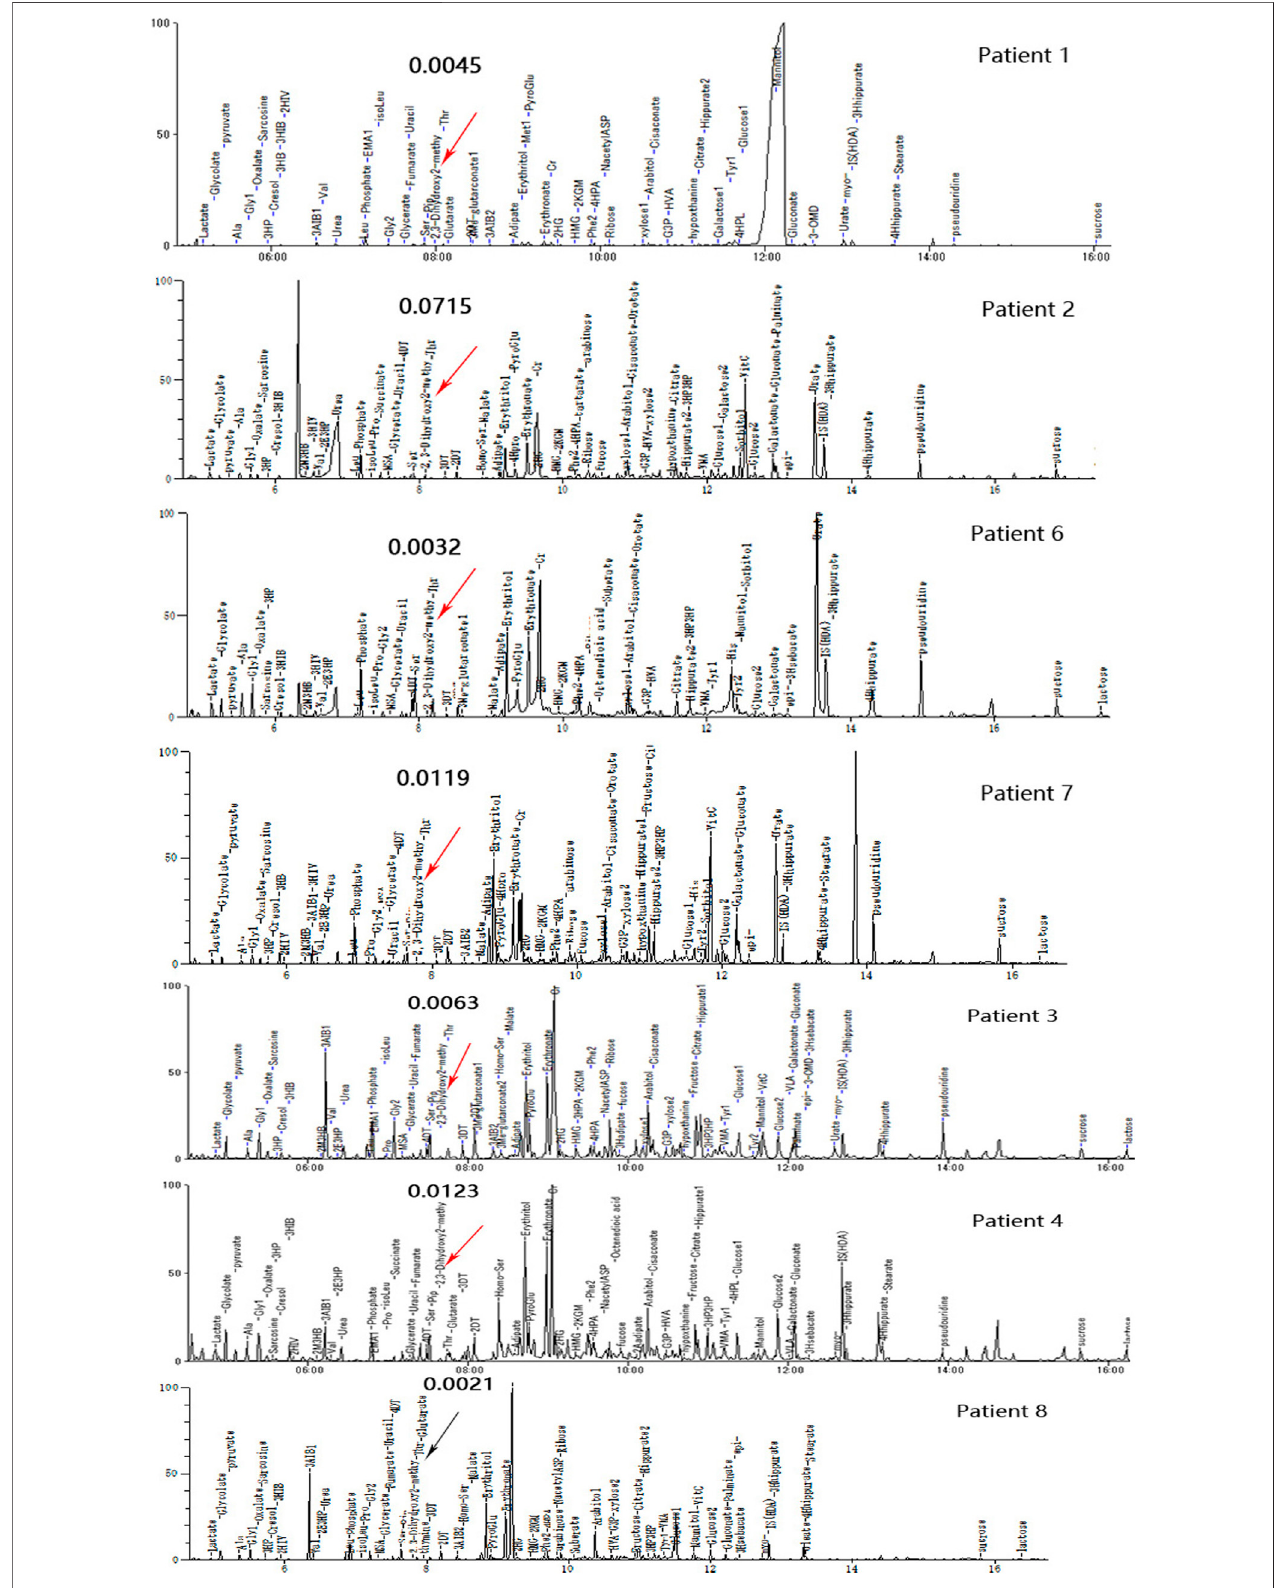
FIGURE3| Urine organic acidpro fi les ofseven patients indifferentphases; red arrows indicate abnormallyhigh 23DH2MB peaks, and theblackarrow represents anormal23DH2MBpeak.Patients1,2,6,and7withelevated23DH2MBlevelsinthepeakstage.Patients3and4withelevated23DH2MBlevelsintherecoverystage. Patient 8 with a normal 23DH2MB level after adopting a valine-restricted diet.